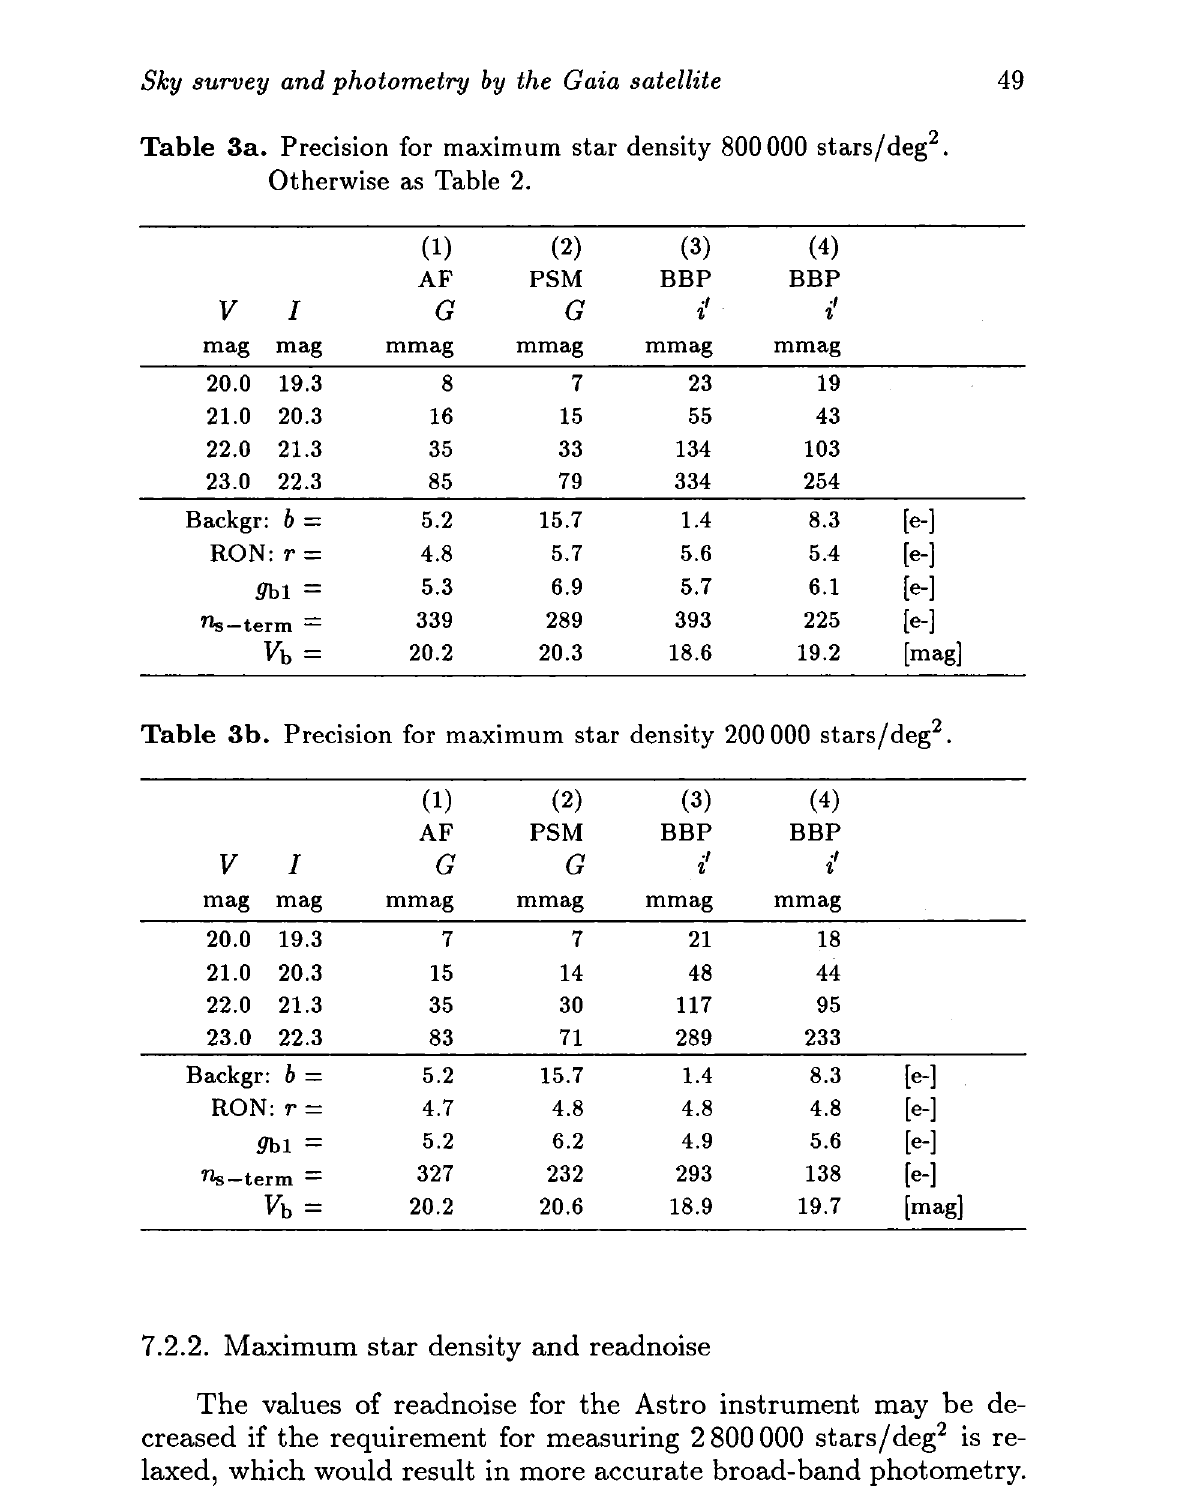
Table 3b. Precision for maximum star density 200 000 stars/deg 2